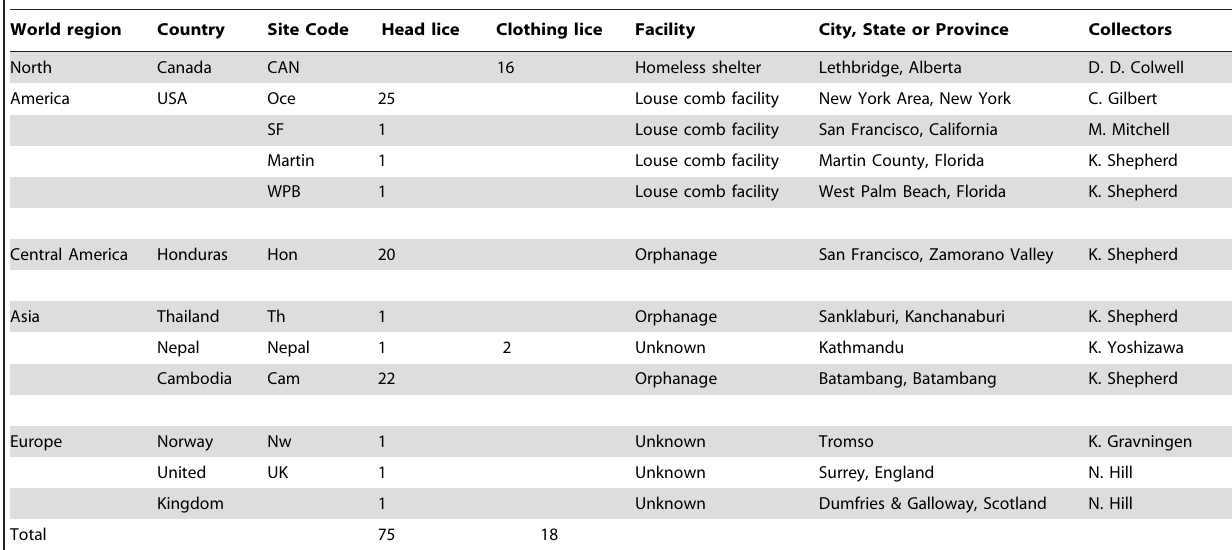
Table 1. Human louse samples used in the current